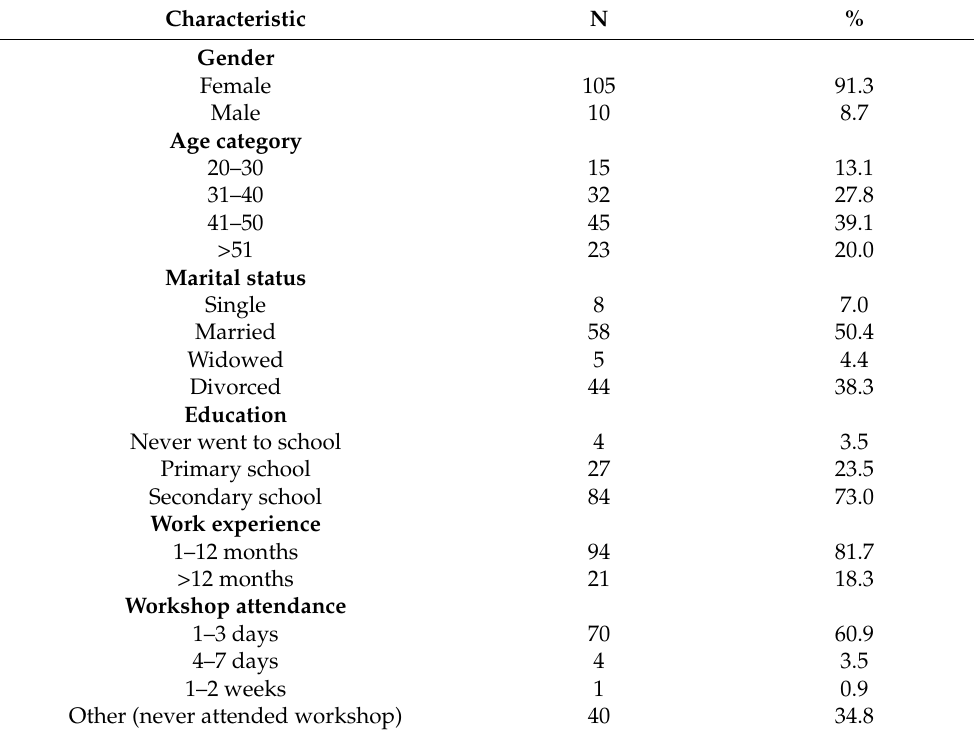
Table 1. Socio-demographic characteristics of volunteer food